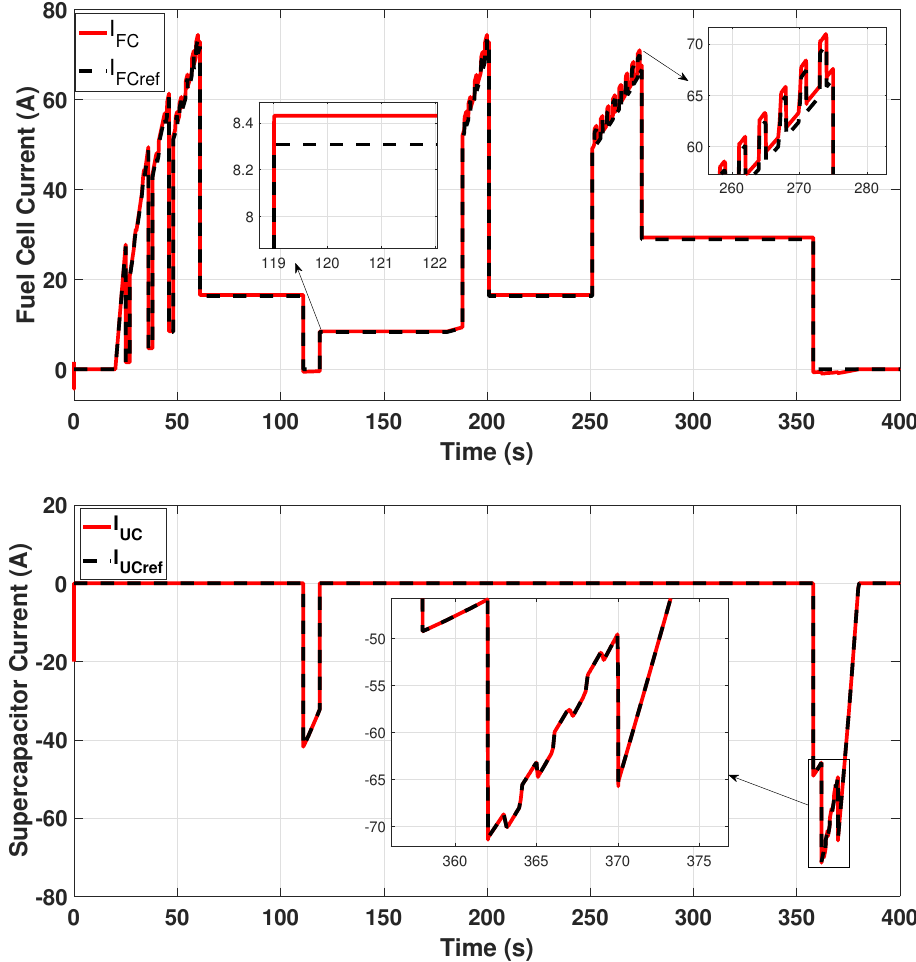
Figure 4. Current tracking using the backstepping-based adaptive controller.